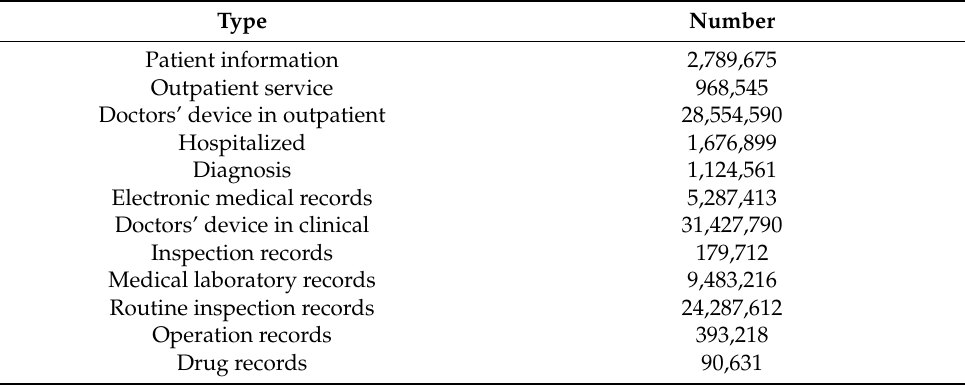
Table 1. Data collection and type analysis of NSCLC in three hospitals.